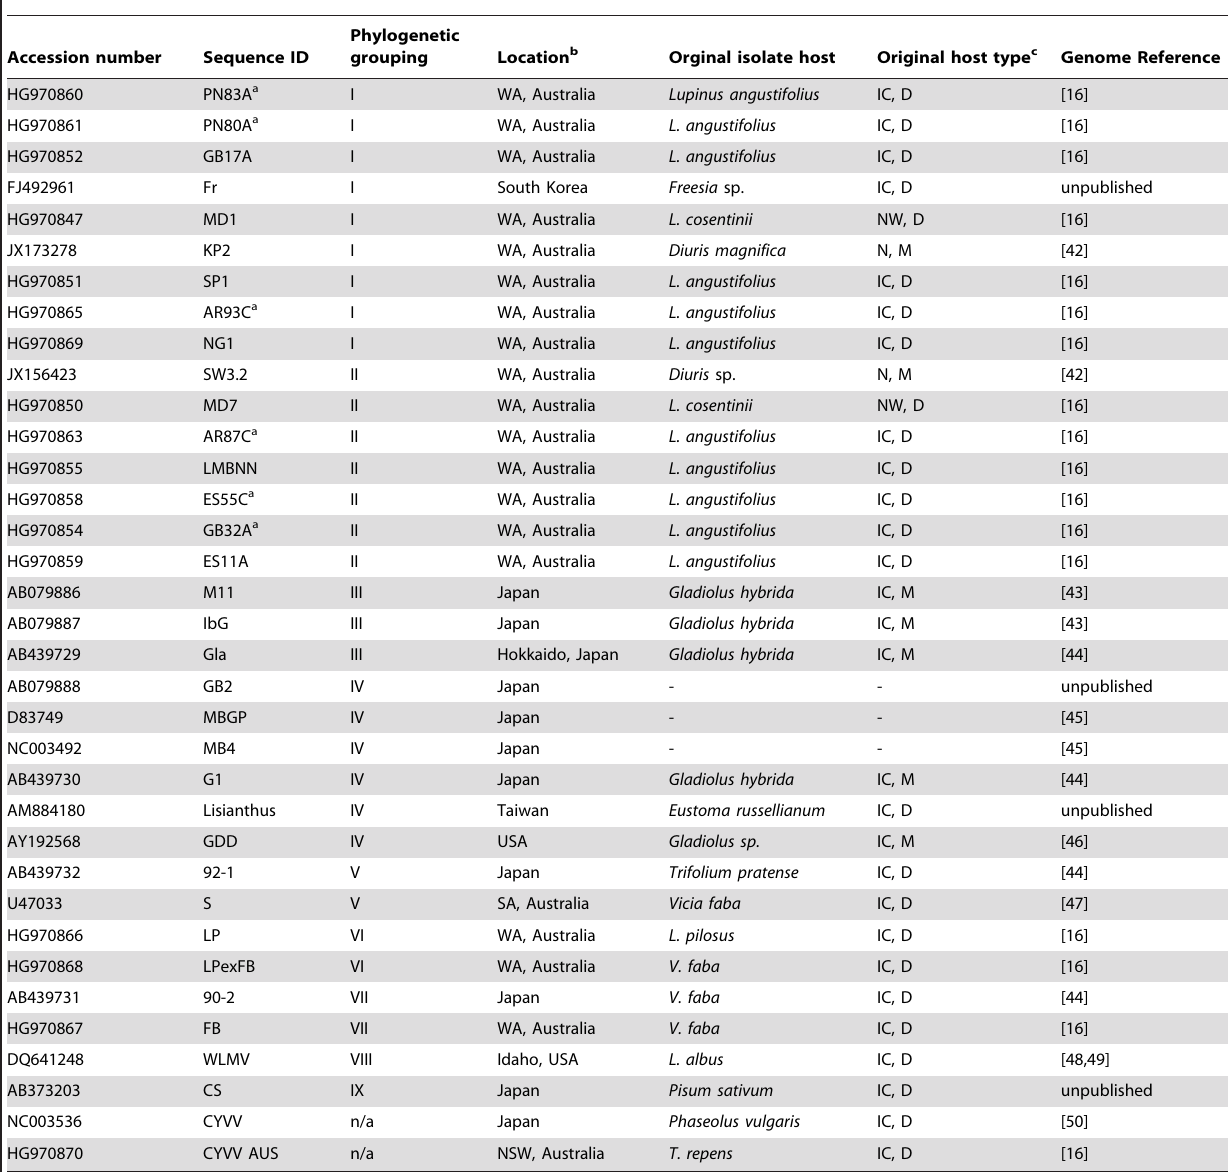
Table 1. Bean yellow mosaic virus and Clover yellow vein virus genomes analyzed for